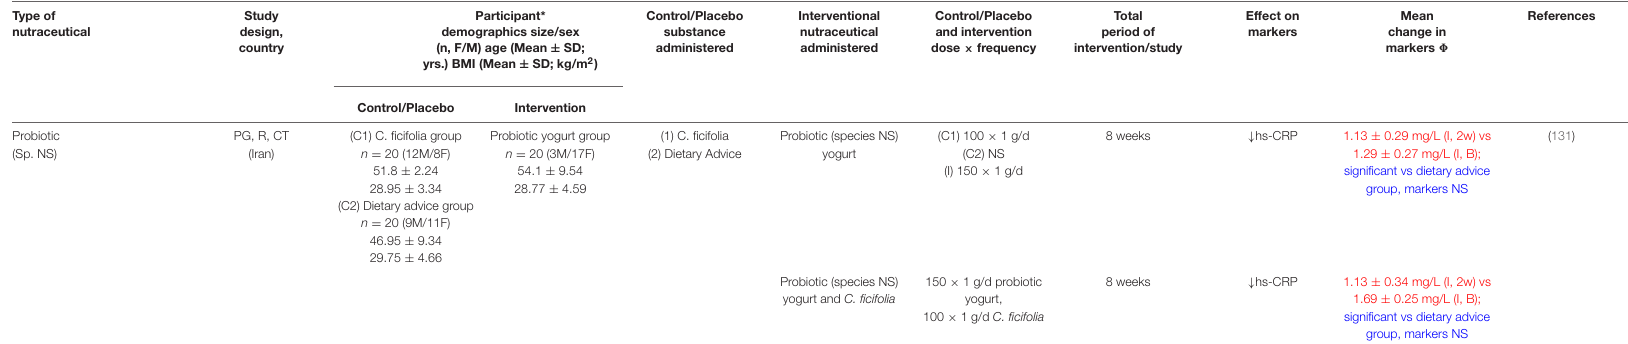
TABLE 2 | (Continued) Typeof